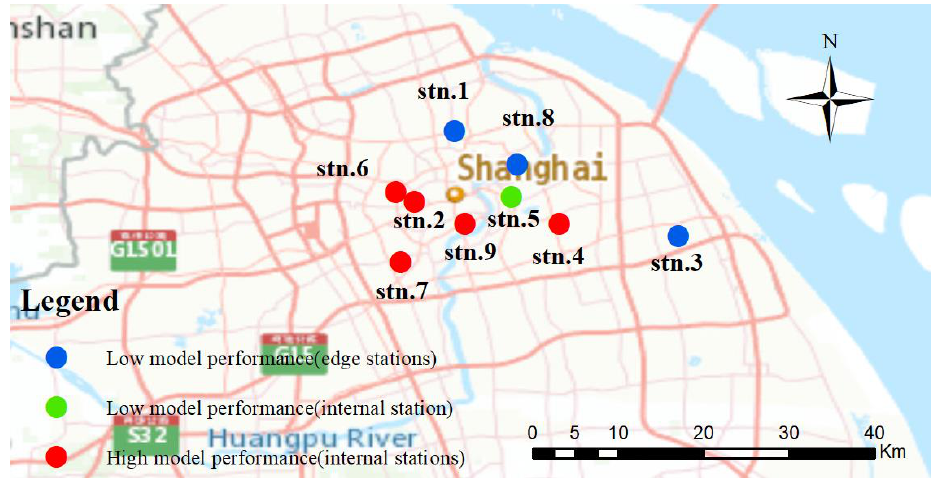
Figure 16. Model prediction performance for different stations.